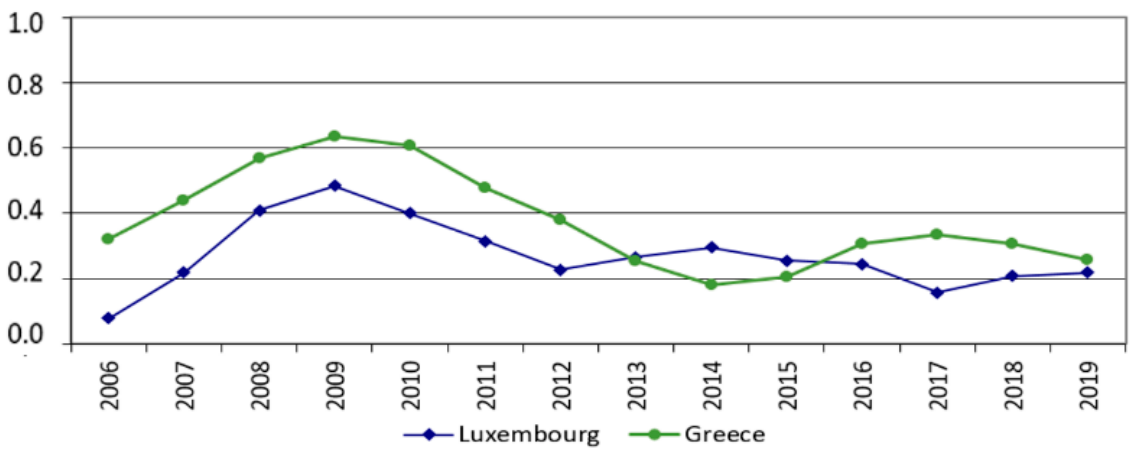
Figure 2. Dynamics of Ki in countries with its growth.